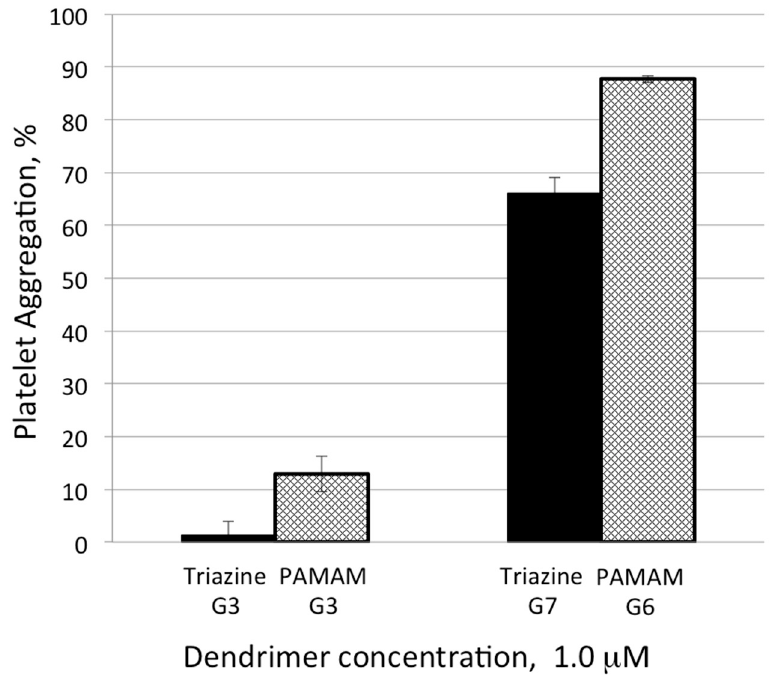
Figure 2. Cationic triazine dendrimers are less reactive with human platelets than cationic PAMAM dendrimers of similar size. G3- and G7-amine-terminated triazine dendrimers and G3- and G6-amine terminated PAMAM dendrimers at equivalent molar concentrations were incubated with human platelet reach plasma for 15 min at 37 °C. After that, platelet count was performed using a Z2 cell and particle counter equipped with a 5-µm aperture tube. Platelet count in the test samples was compared to that in the negative control sample to calculate percent platelet aggregation. Collagen was used as an assay positive control (data not shown). Shown is mean ± SD ( n = 3).